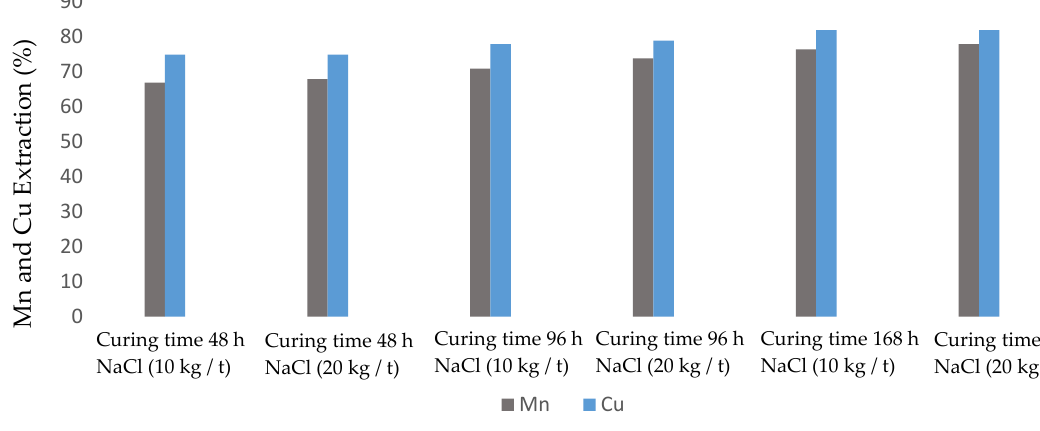
Figure 4. E ff ect of NaCl concentration and cure time on the dissolution of Mn and Cu. Figure 4. Effect of NaCl concentration and cure time on the dissolution of Mn and Cu.